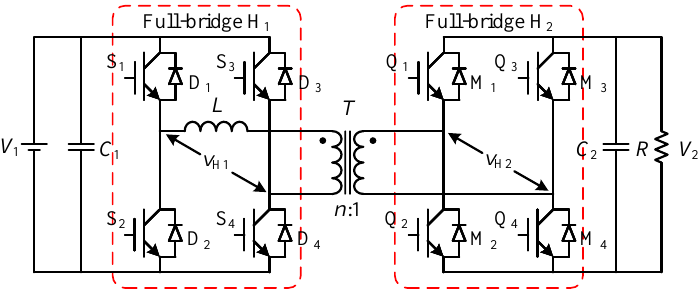
Figure 1. Topology of a DAB converter.